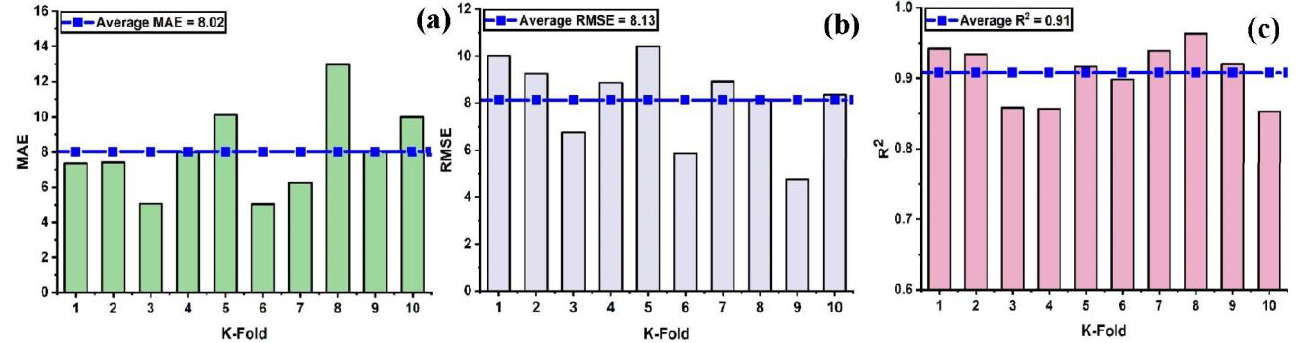
Figure 10. Cross validation; ( a ) SVR-bagging with MAE; ( b ) SVR- bagging with RMSE; ( c ) SVR- bagging with R 2 .